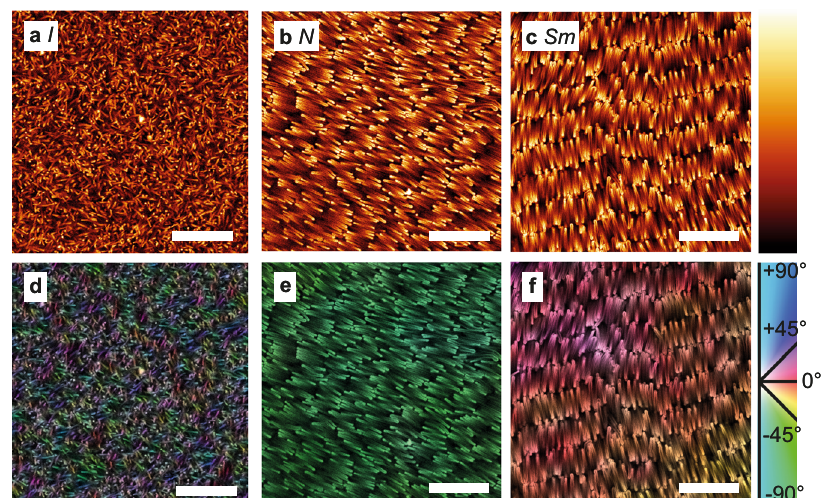
Fig. 2 | Liquid crystal phases of fl uorescently labeled bent silica rods (BSRs) from a sedimentation-diffusion equilibrium pro fi le, as imaged with fl uores- cence confocal microscopy. a Isotropic ( I ) phase (above 14±1 μ m from the bot- tom surface), b Nematic ( N ) phase (between 8±1 μ m and 14±1 μ m) and c Smectic ( Sm ) phase (from the bottom surface to the N phase). On the right, color code for